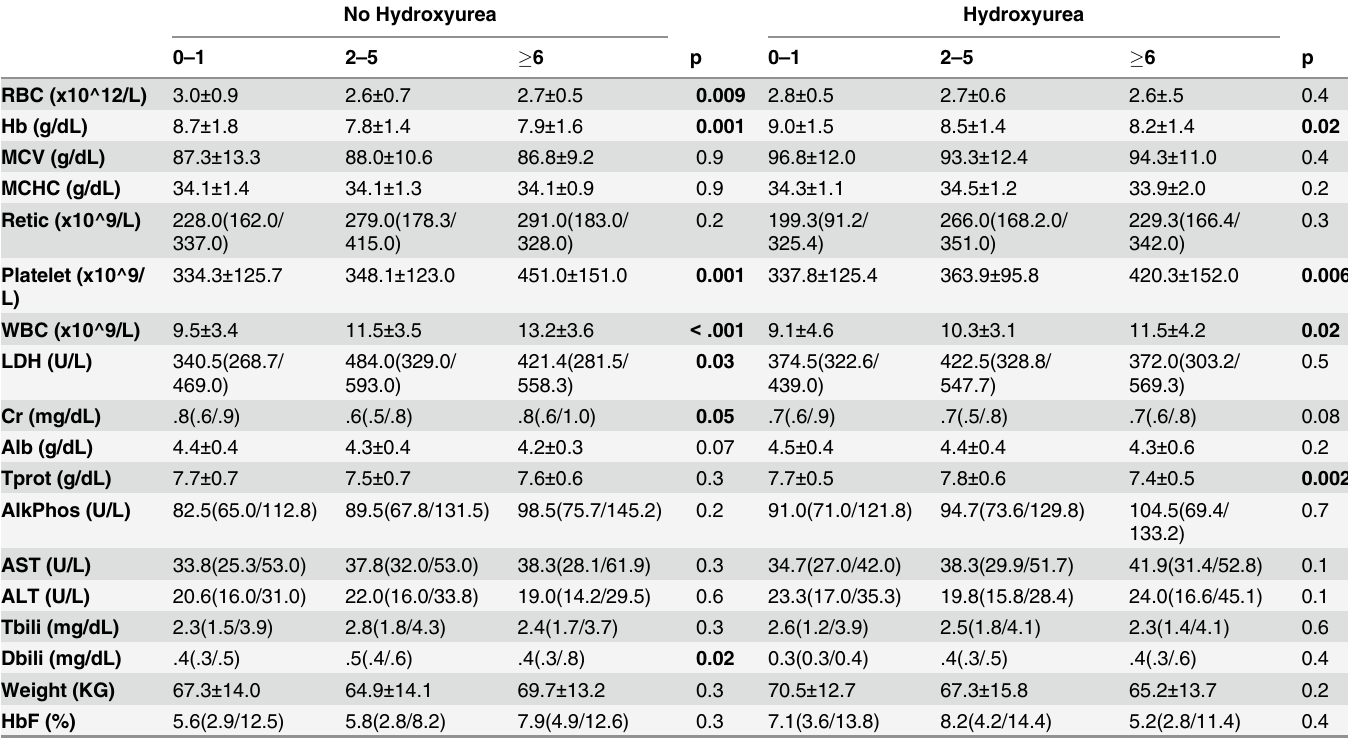
Table 4. Steady state laboratory determinants for each ED utilization cohort according to hydroxyurea use. Normalized data reported as means with SDs, non-normalized data reported as medians with 25% and 75% P values are for ANOVAs done over all 3